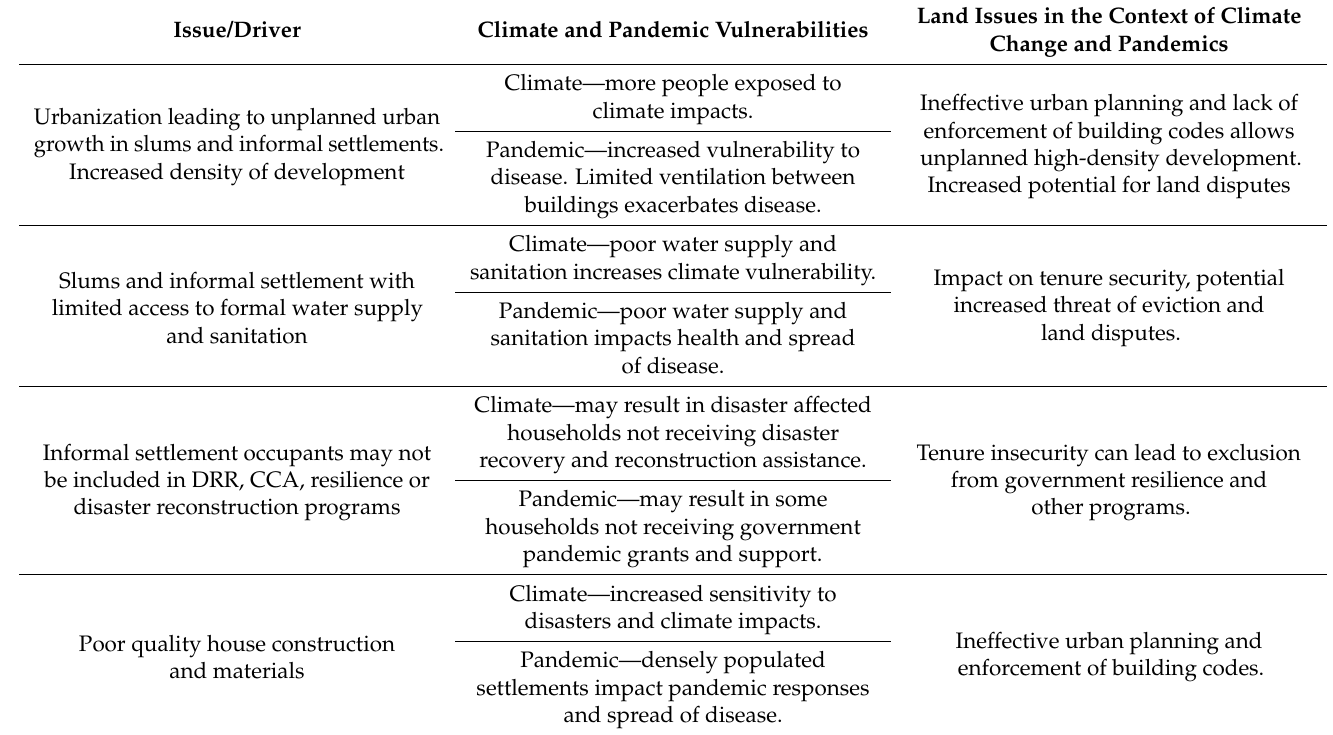
Table 3. Key interlinkages between land tenure and climate and pandemic